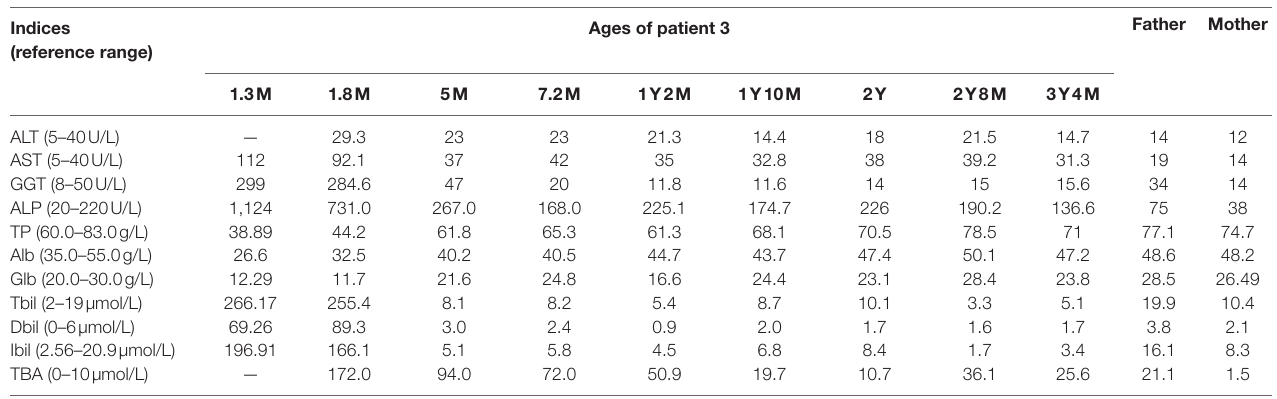
TABLE 3 | Biochemical indices over time in patient 3 and the